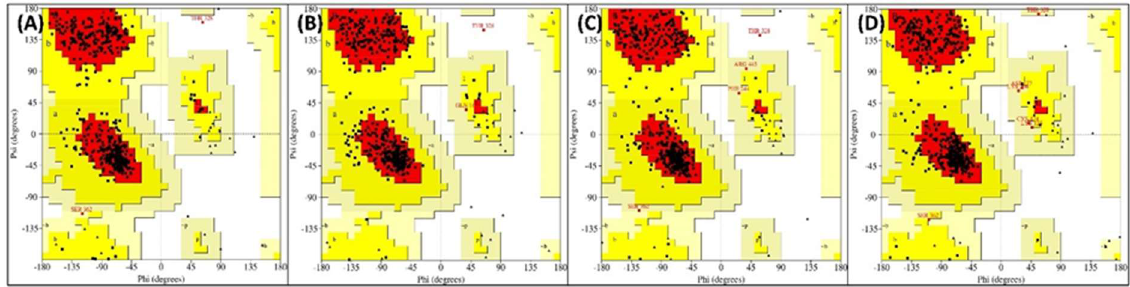
Figure 8. ( A ) Ramachandran plot of the energy minima structures of PKM2 alone. ( B ) Ramachan- dran plot of the energy minima structures of PKM2-Lut complex. ( C ) Ramachandran plot of the energy minima structures of PKM2-Rut complex. ( D ) Ramachandran plot of the energy minima structures of PKM2-Ver complex.